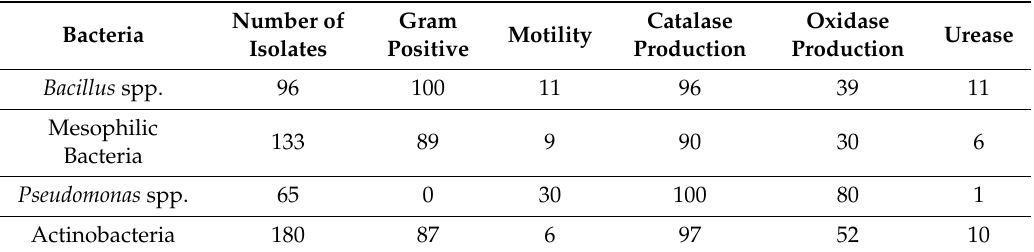
Table 3. Screening on some phenotypic tests on the isolates. Percentages of isolates positive to the test. The motility was evaluated at the optimal temperatures (30 ◦ C for mesophilic and spore-forming bacteria, 22 and 25 ◦ C for actinobacteria and